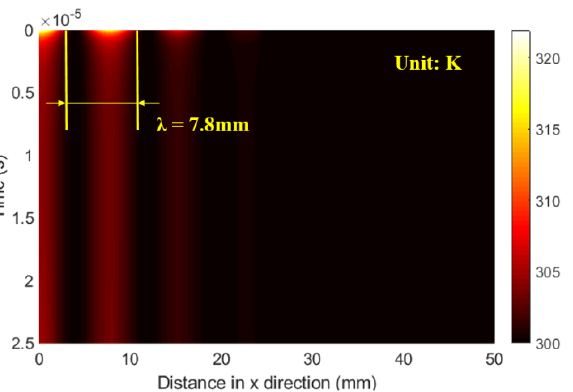
Figure 9. Temperature field distribution as a result of thermoelastic laser excitation when λ =